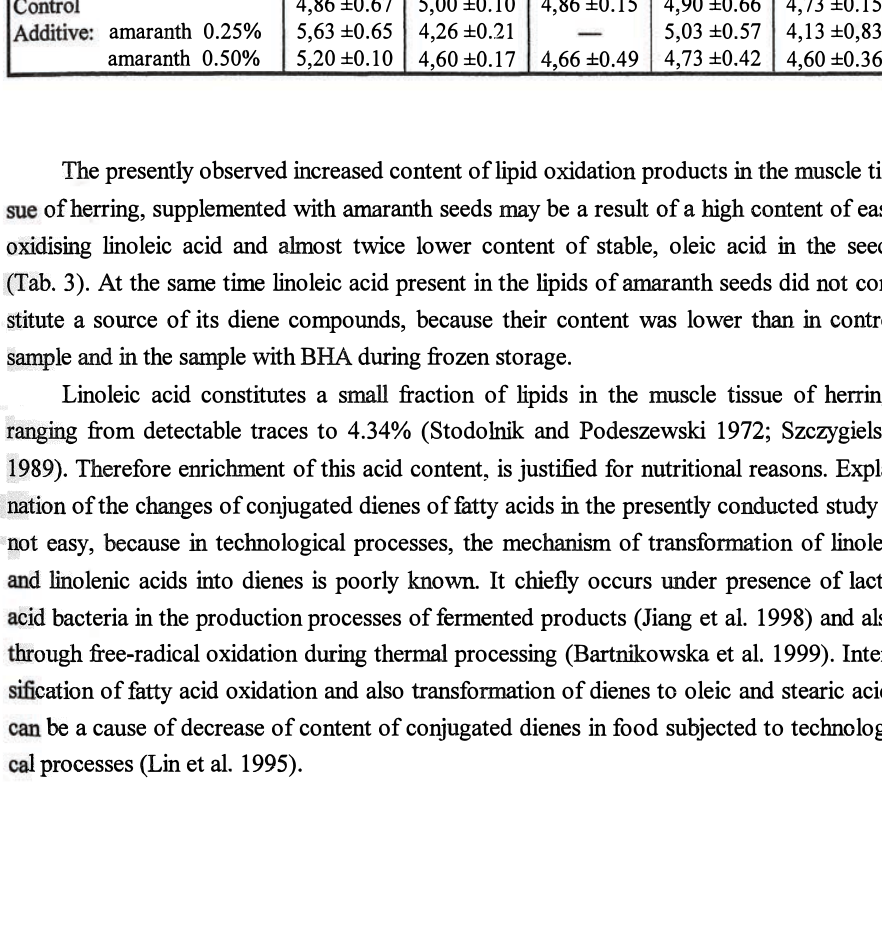
Changes in hardness value ( cm 2 /g) of herring muscle tissue during frozen storage ( x ±SD) Stora e time Sample